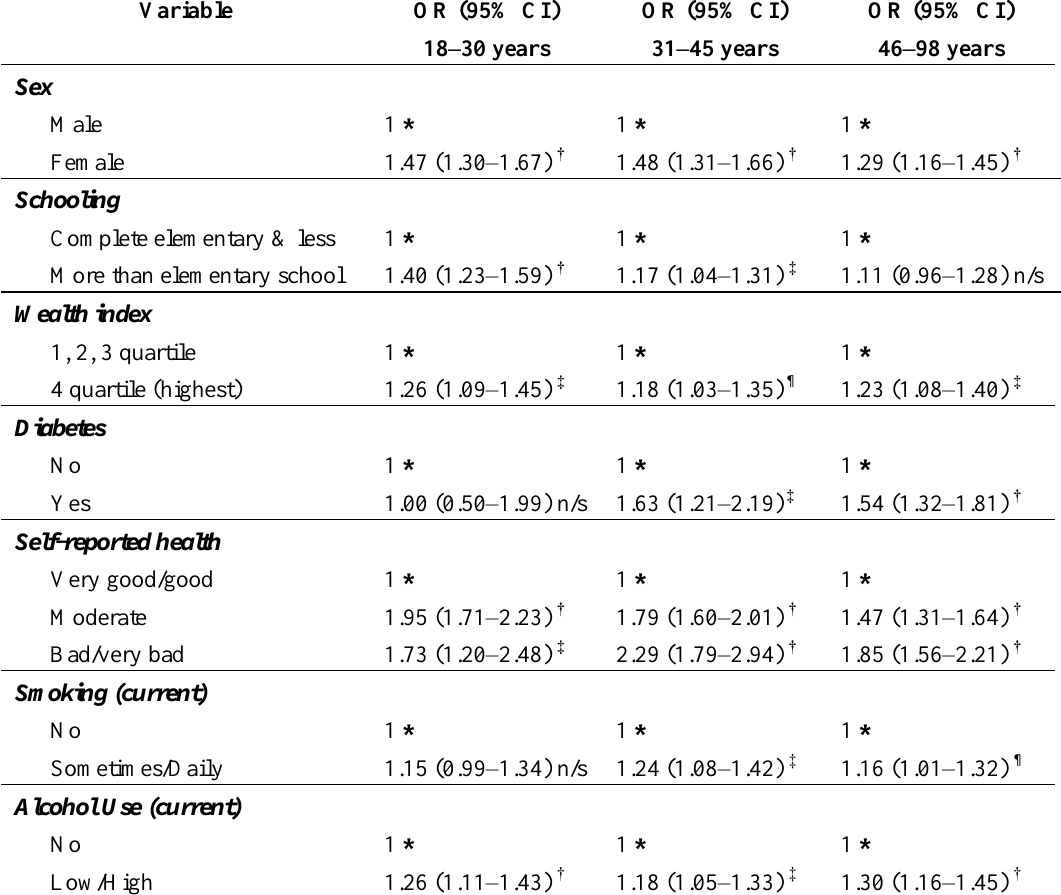
Table 3. Results of multivariate logistic regression models for each one of the three age groups on the prevalence of self-reported oral and dental problems and independent variables (National Performance Evaluation Survey